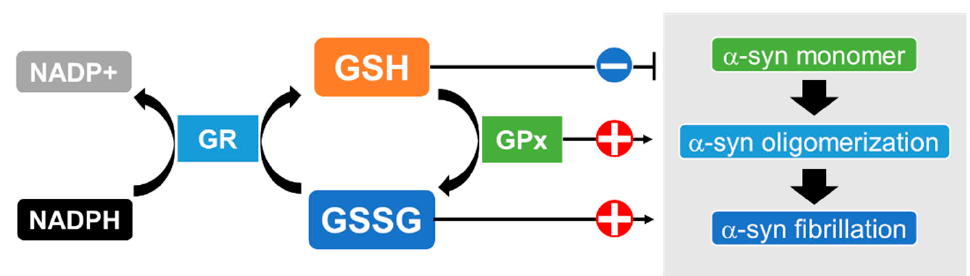
Figure 2. Association between the state of α -synuclein and conversion of GSH and GSSG. The states of α -synuclein ( α -syn) may depend on the redox states of glutathione, which are regulated by glutathione reductase (GR) and glutathione peroxidase (GPx). GR transfers an electron from nicotinamide adenine dinucleotide phosphate (NADPH) to GSSG and thereby catalyzes the reduction of GSSG to GSH. GPx reduces peroxide to a harmless GSSG. In addition, GPx markedly enhances the fibrillation of α